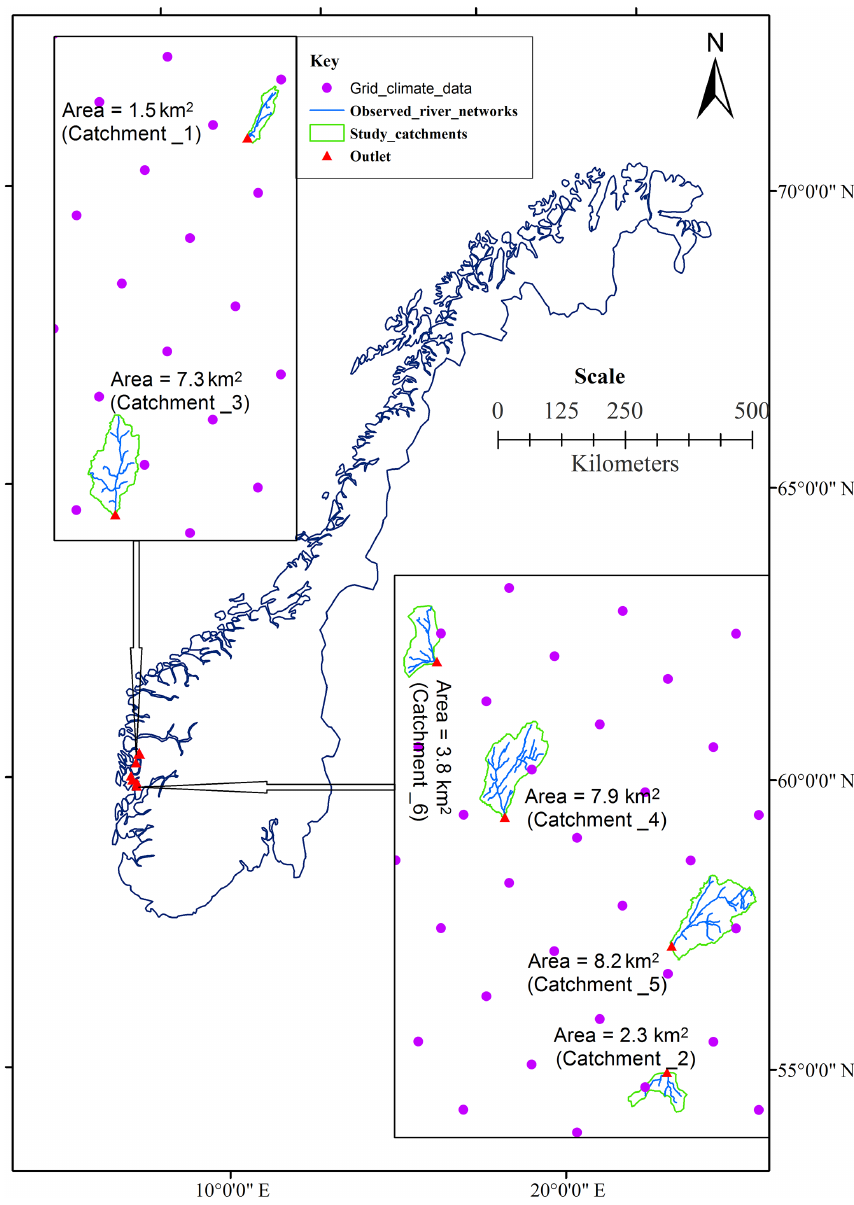
Figure 1. Locations of study catchments in